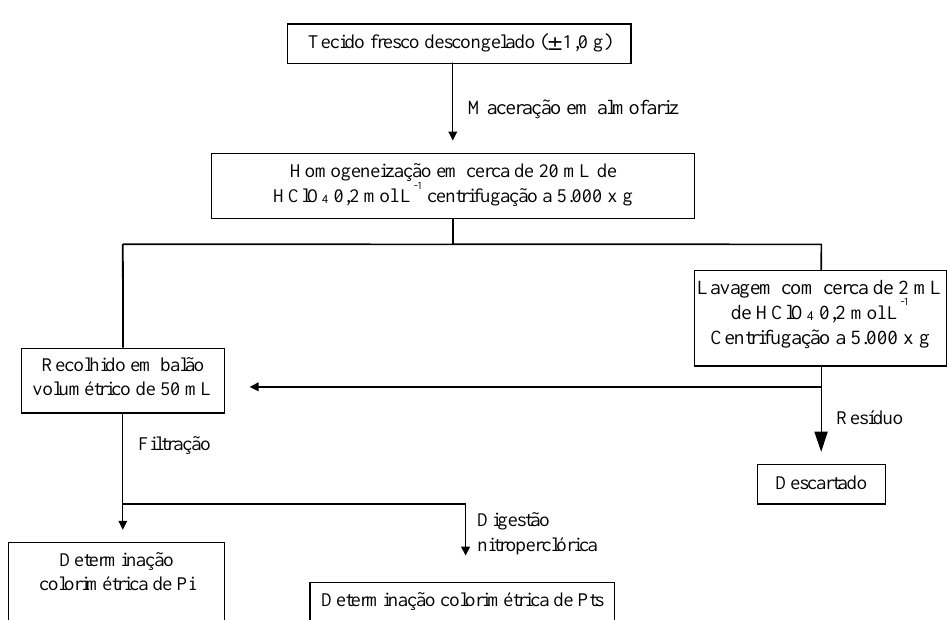
Figura 1. Fluxograma do método empregado no fracionamento de P (Martinez, 1992).